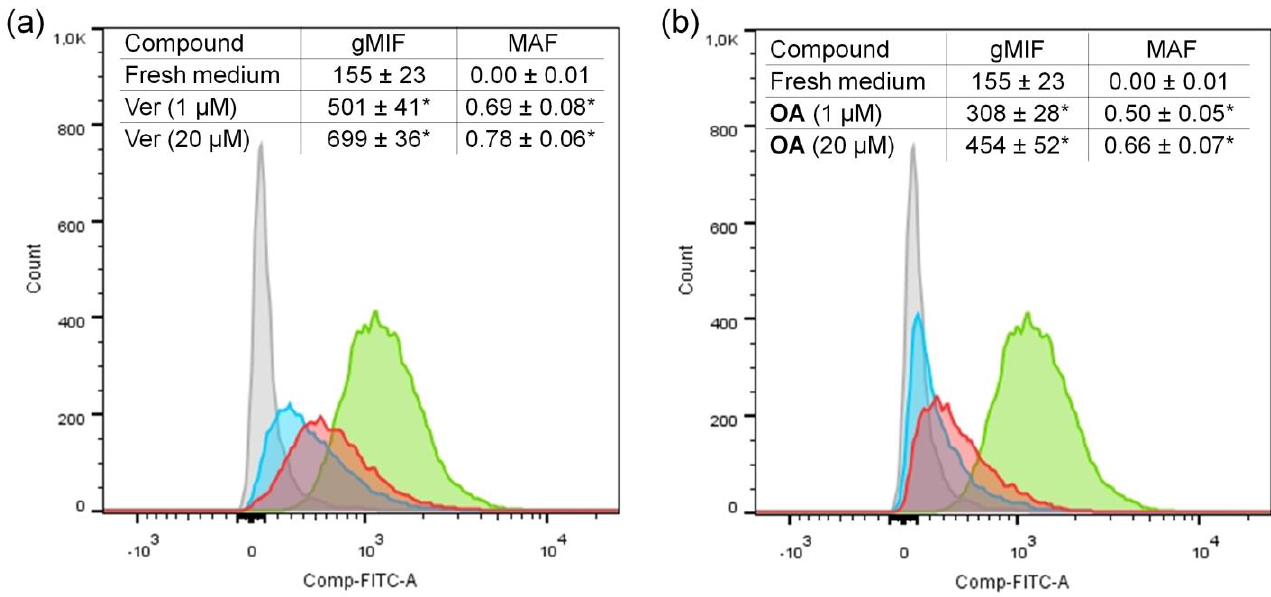
Figure 4. The effect of ( a ) verapamil and ( b ) OA on Rh123 efflux from K562/iS9_Dox resistant cells. After 20 min staining with Rh123, the cells were further incubated for 30 min in fresh medium, medium with verapamil or OA . Cell luminosity after incubation with Rh123 (green line) followed by incubation in fresh medium (grey area) ( a ) in medium with 1.0 µ M (blue line) or 20.0 µ M (red line) verapamil, and ( b ) in medium with 1.0 µ M (blue line) or 20.0 µ M (red line) OA . * Statistical significance of gene expression values as compared to fresh medium ( p <